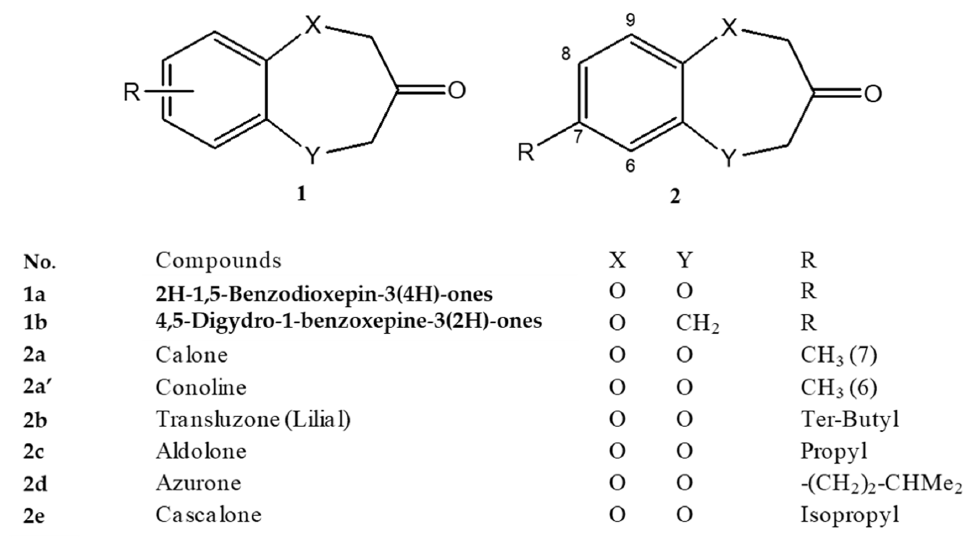
Figure 2. Structure of benzodioxepinone and benzoxepinone skeletons, Calone and